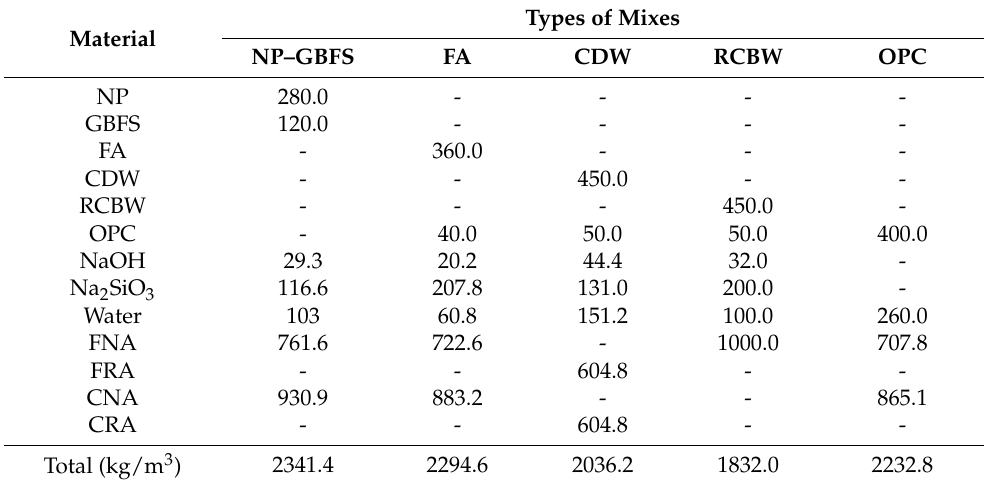
Table 3. Proportion of the mixtures (kg/m 3 ) used to produce the blocks.